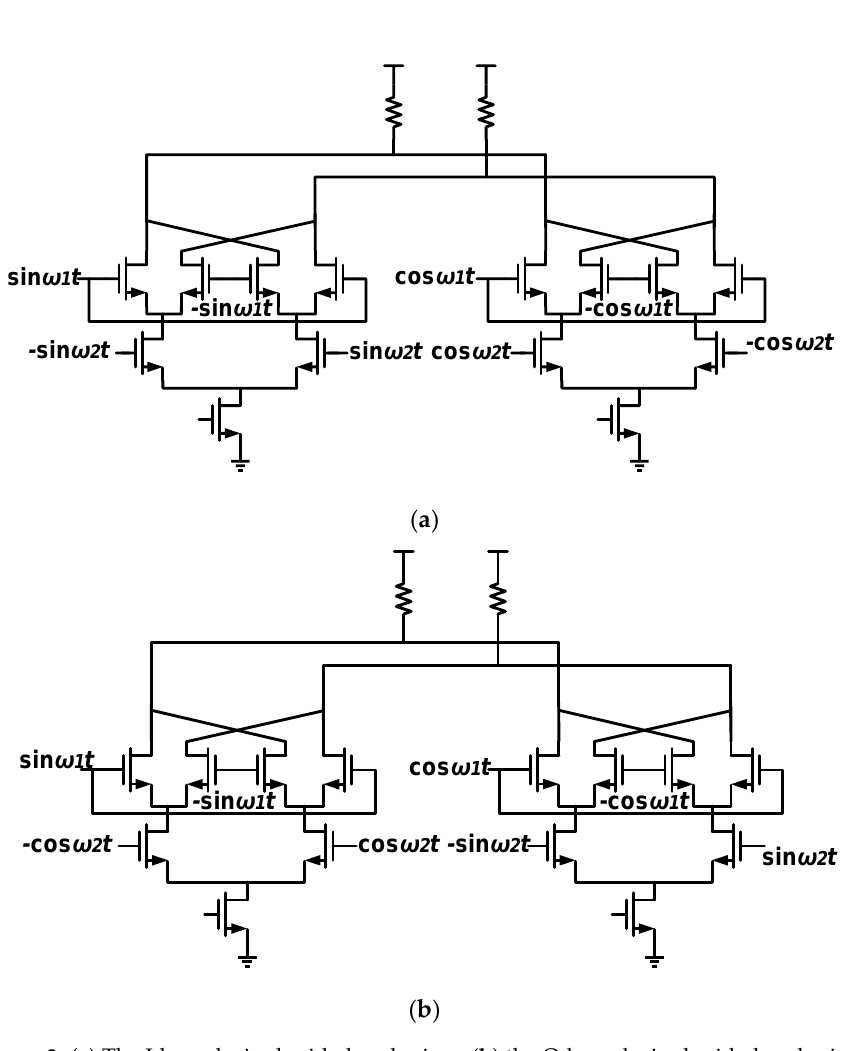
Figure 3. ( a ) The I-branch single side-band mixer; ( b ) the Q-branch single side-band mixer.